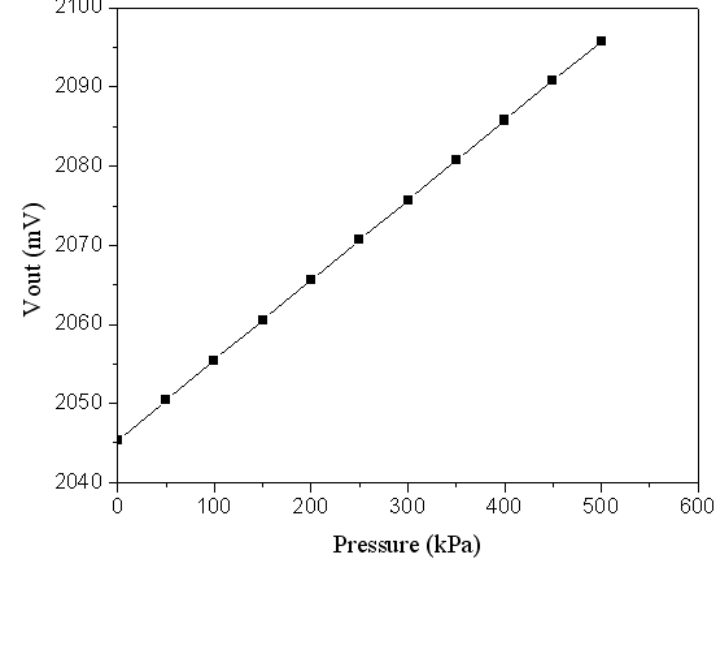
Figure 8. Simulated results of the output voltage in the pressure